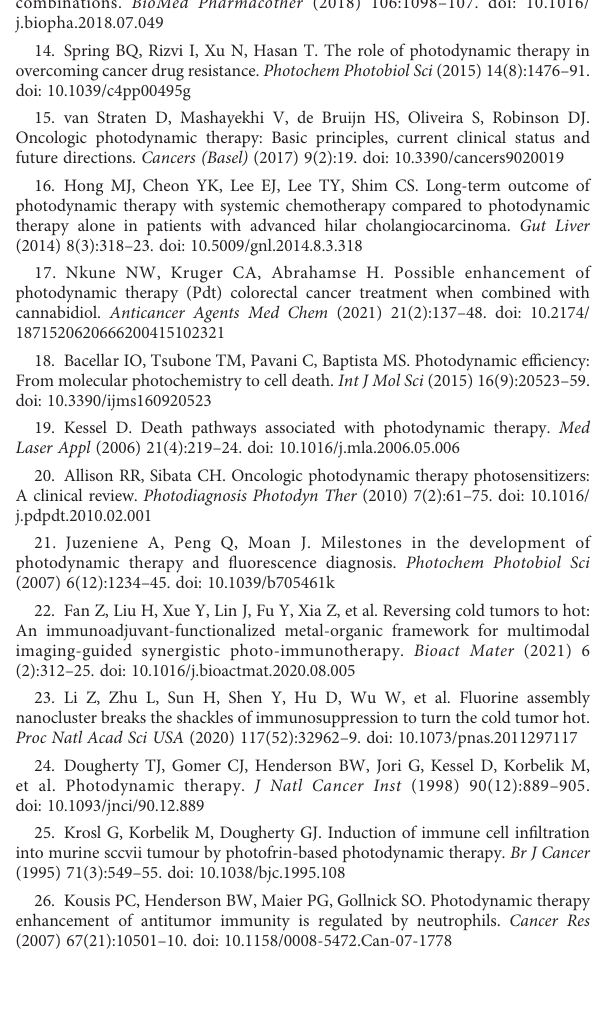
SUPPLEMENTARY FIGURE 1 Immune cell in fi ltration in tumor tissues of CRC patients before and after 48h PDT (n=6). The results showed that T cells ( p =0.0053), B cells ( p =0.0216), CD4 + T cells ( p =0.0341), CD8 + T cells ( p =0.0132), and macrophages ( p =0.0172) increased signi fi cantly after PDT, and NK cells did not change